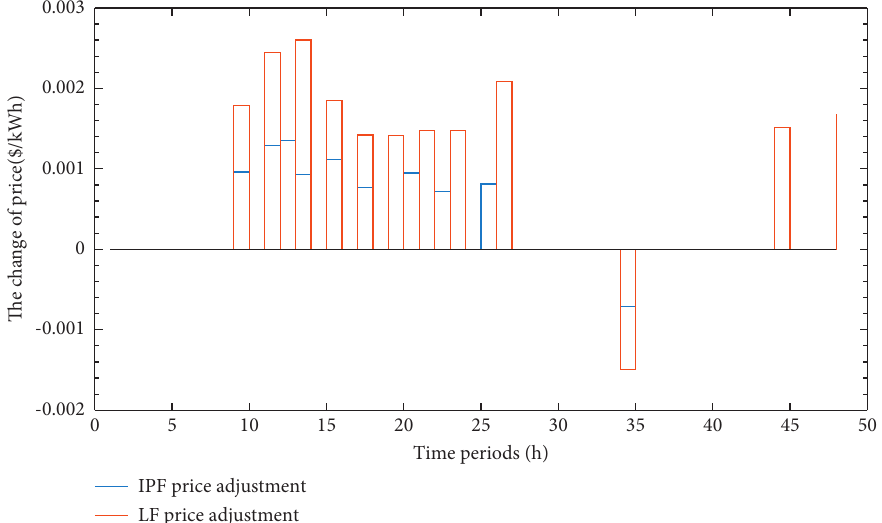
Figure 7: Comparison of price changes (blue solid lines denote IPF price adjustment and red solid lines depict LF price